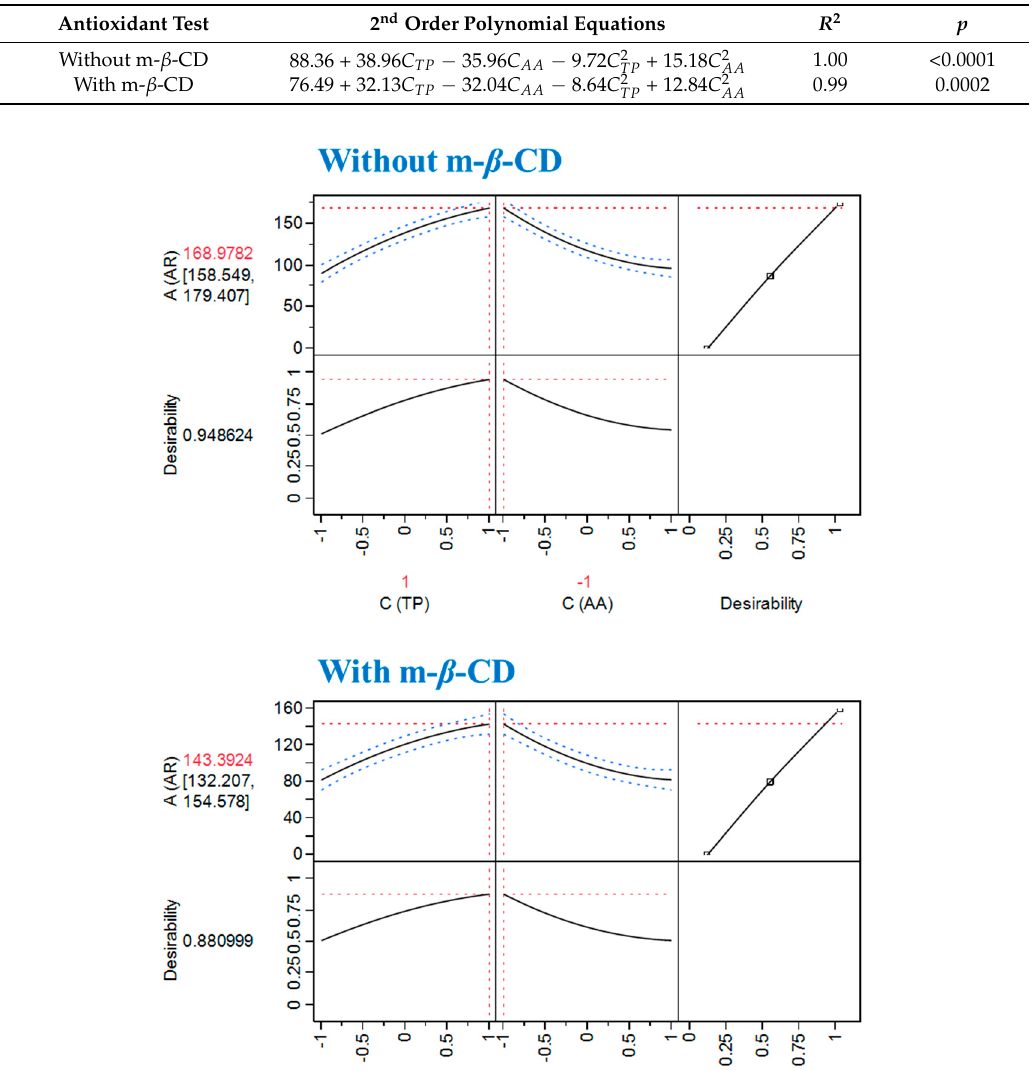
Table 3 . Polynomial equations and statistical parameters describing the effect of the independent variables on the response ( A AR ) for all OLL/AA mixtures tested.